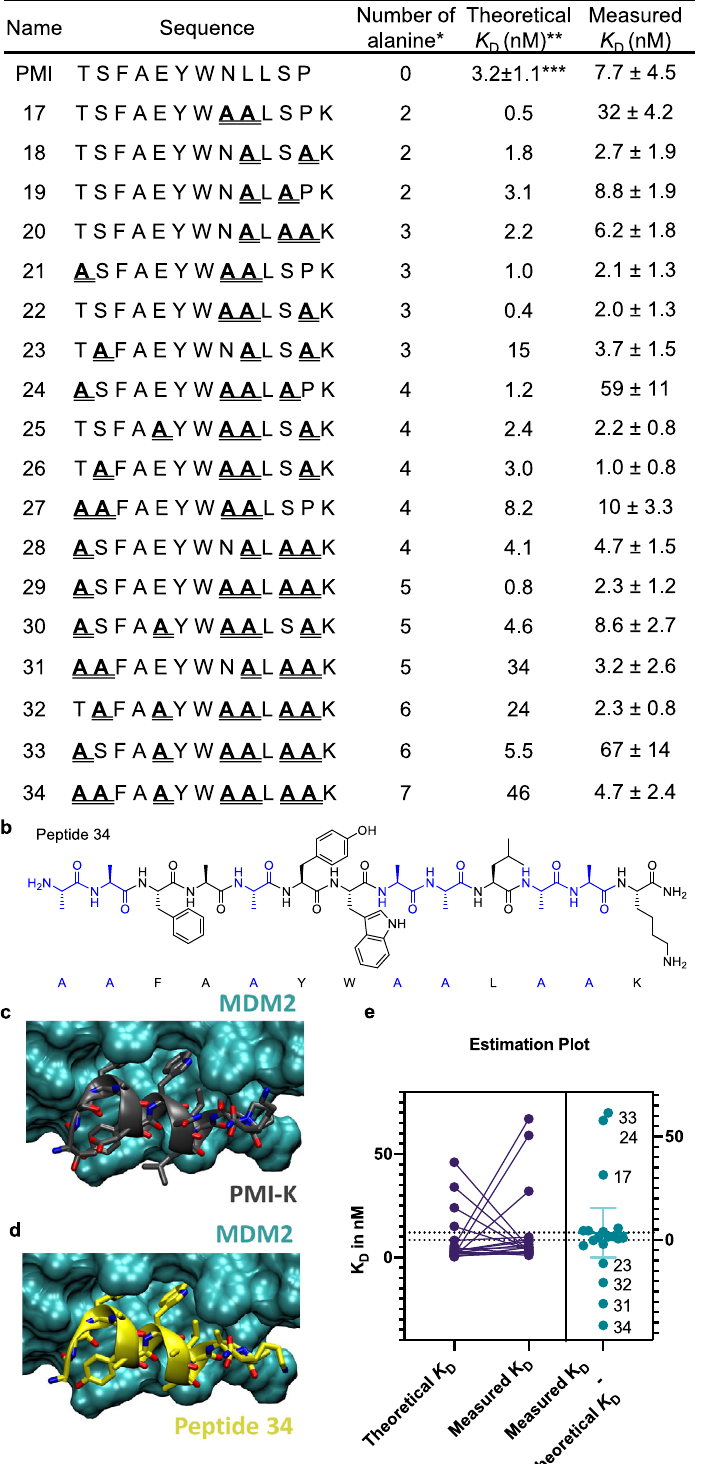
Fig. 4 Multiple alanine-substituted peptides exhibit nanomolar binding af fi nity. a A subset of alanine-substituted peptides were identi fi ed and resynthesized and validated after increasing the selection stringency. Dissociation constants ( K D ) were determined by a competition assay using BLI. *Ala4 is not considered. **Theoretical K D ( K D ’ ) was calculated by adding the residue-speci fi c energy contributions of individual alanine mutations (detailed calculation described in Supplementary Fig. 4). ***The reported K D of PMI 25 . b A 13-mer peptide 34 with seven alanine substitutions was identi fi ed ( K D = 4.7 ± 2.5 nM). Molecular docking results of ( c ) PMI-K (gray) and ( d ) peptide 34 (yellow) bound to MDM2 (cyan). e Paired t-test of theoretical K D ’ and measured K D . The left plot shows the K D and K D ’ values. The right plot denotes the mean of difference calculated from the paired t-test. Error bar denotes 95% con fi dence